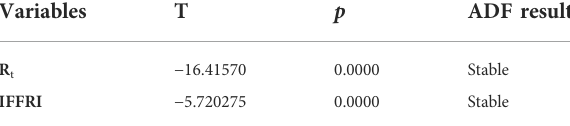
TABLE 1 ADF test result.